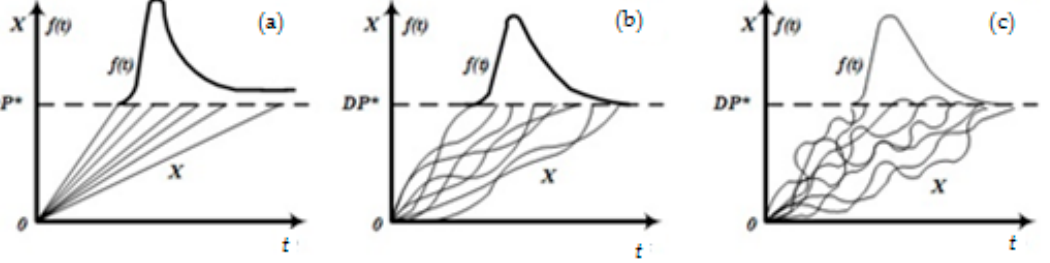
Figure 6. The model of a random degradation process and a scheme for the formation of a time-to-failure distribution: ( a ) α distribution (fan process); ( b ) DN distribution law; ( c ) DM distribution law.